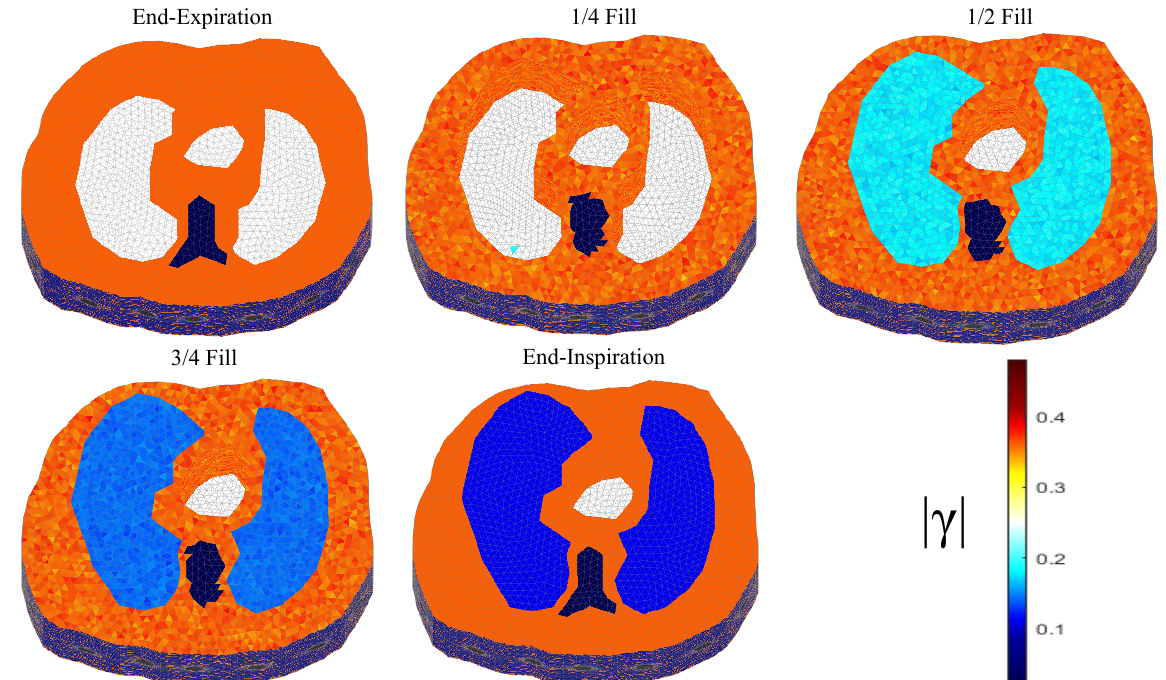
Figure 4. The 3D structure for the 3rd subject case in 5 breath cycle